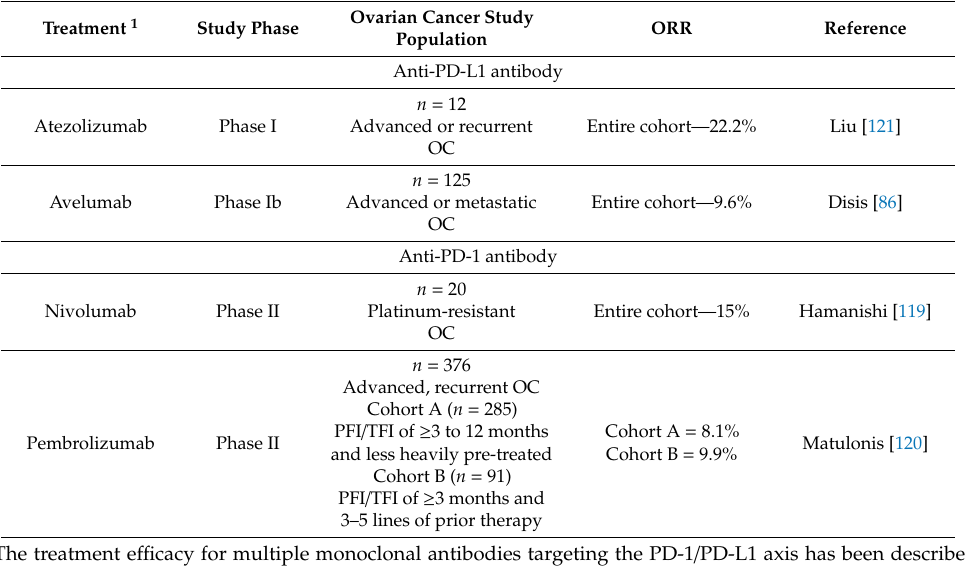
Table 3. Clinical trials data for select immune checkpoint inhibitors evaluated as monotherapy in ovarian